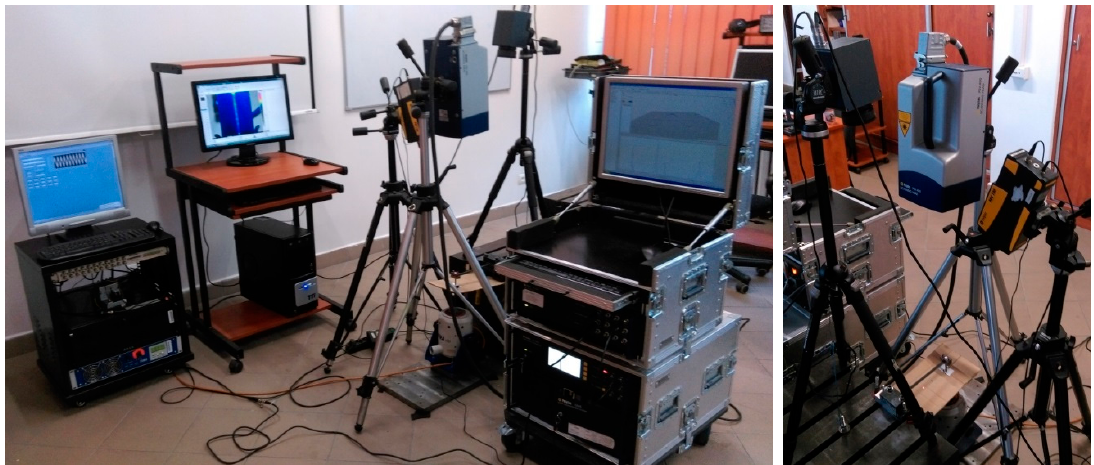
Figure 21. Testing apparatus for performing self-heating-based vibrothermography (SHVT) tests.